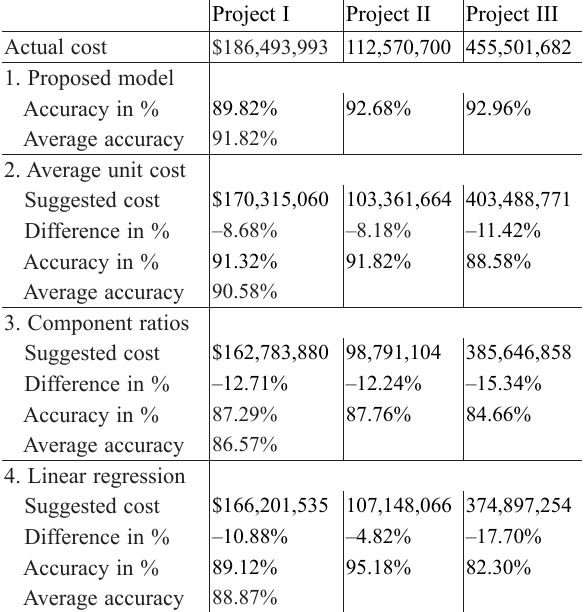
Table 11. Comparisons of evaluation results using various estimation methods for three test projects